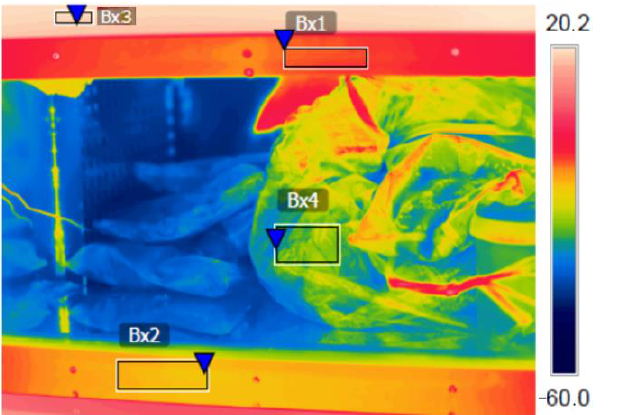
Figure 11. Thermogram for the loaded chamber 2 of the freezing module.